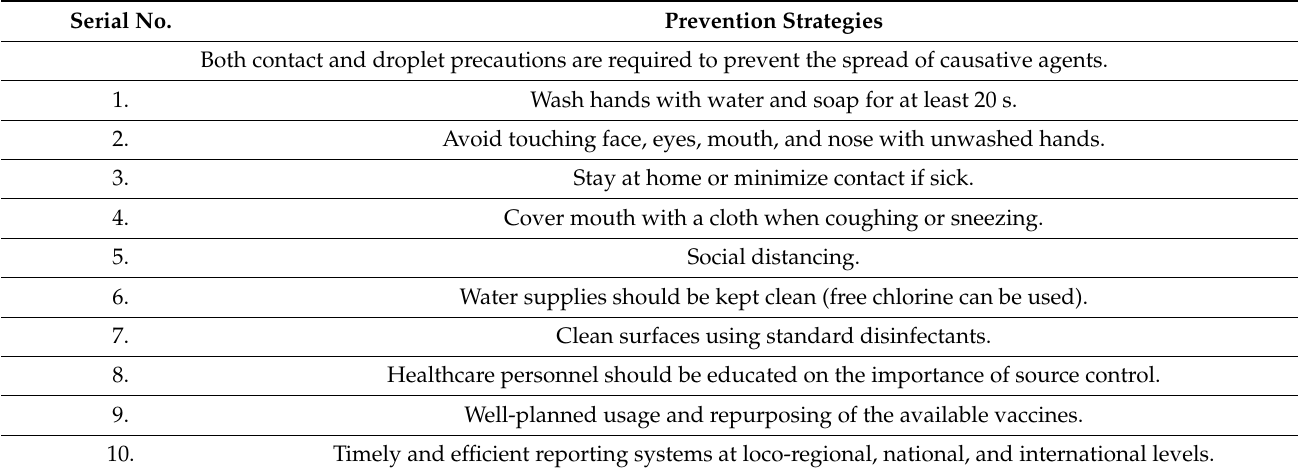
Table 1. Preventive strategies for hepatitis of unknown